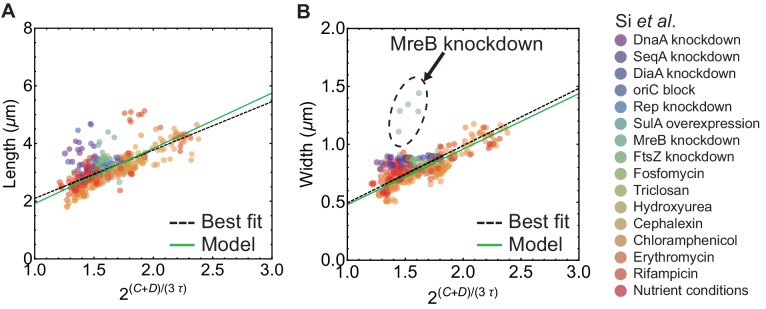
Control of cell width and length in E. coli.Cell length (A) and width (B) vs 2(C+D)/τ. Data used from Si et al. (2017). Here C is time from initiation to termination of DNA replication, D is time from termination of DNA replication to cell division, and τ is doubling time. Green solid lines are calculated assuming S=2⁢π⁢V2/3. Dashed black lines are best fit curves.